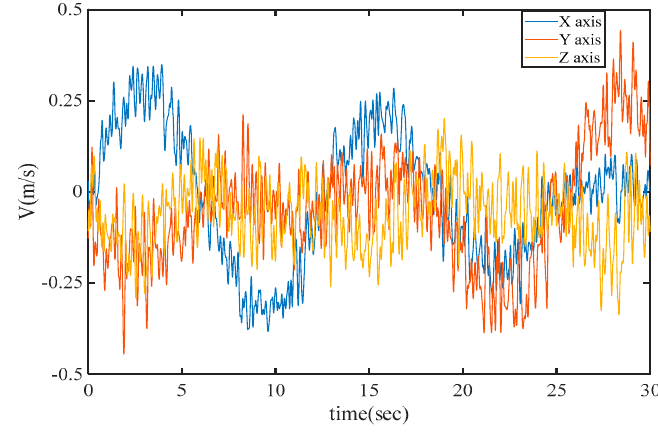
Figure 11. Dryden disturbances model.